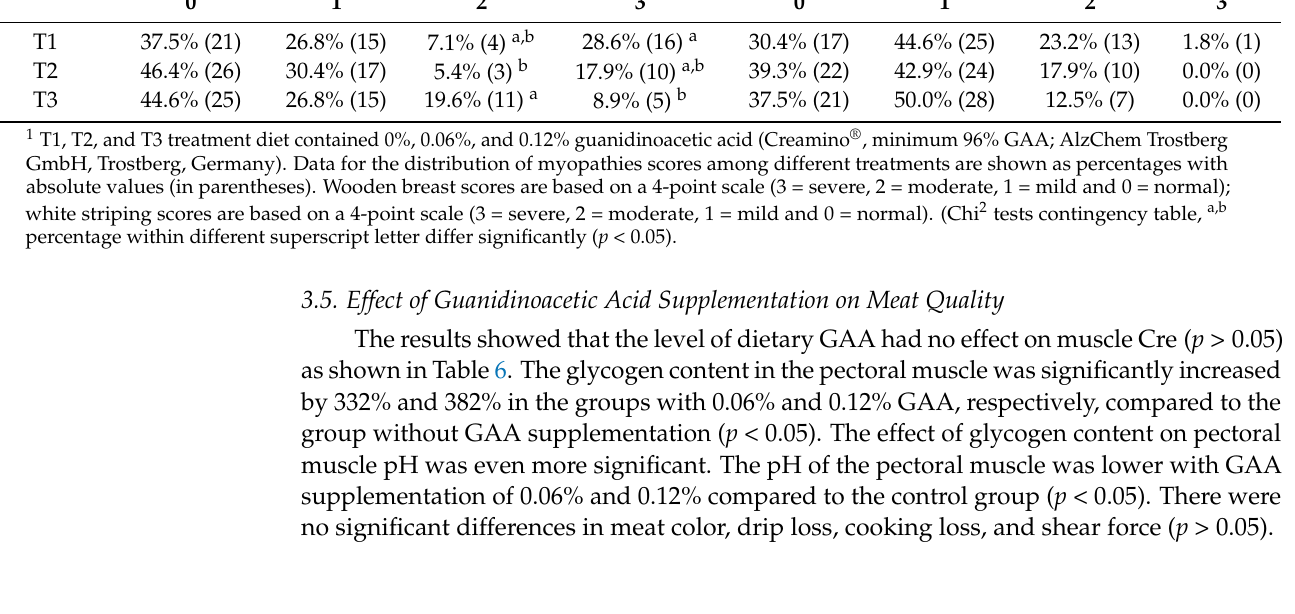
Table 5. Effect of guanidinoacetic acid (GAA) dietary supplementation 1 for male broilers on wooden breast and white stripping percentage % and frequency ( n ) of each score severity at 42 days of age. Wooden Breast Scores White Striping Treatments